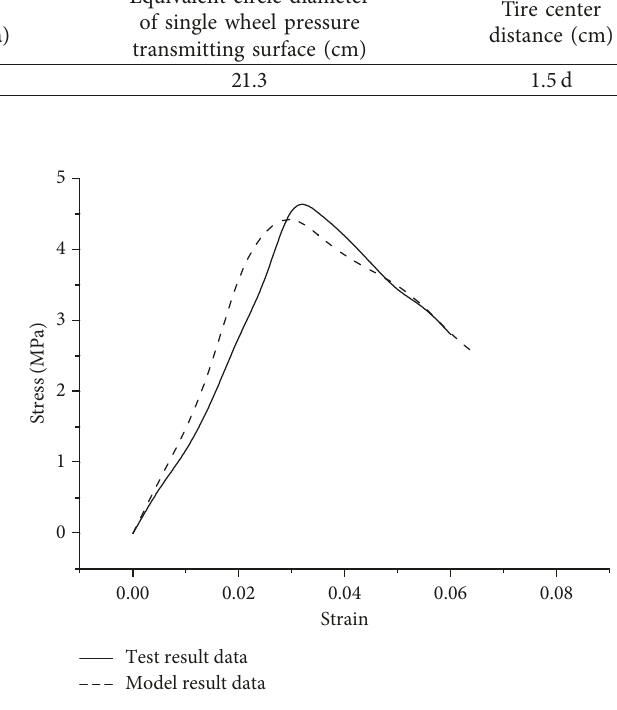
Figure 4: Stress-strain data of SMA-13 asphalt